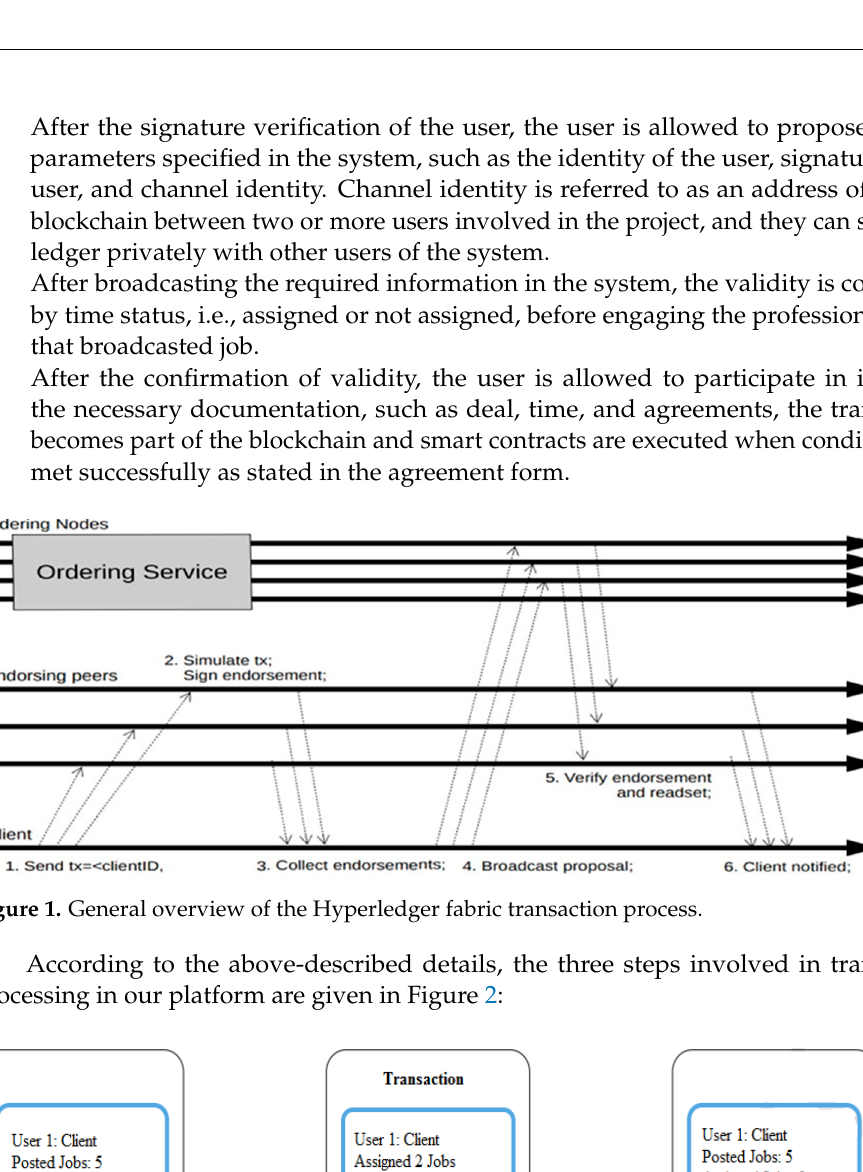
Figure 1. General overview of the Hyperledger fabric transaction process.